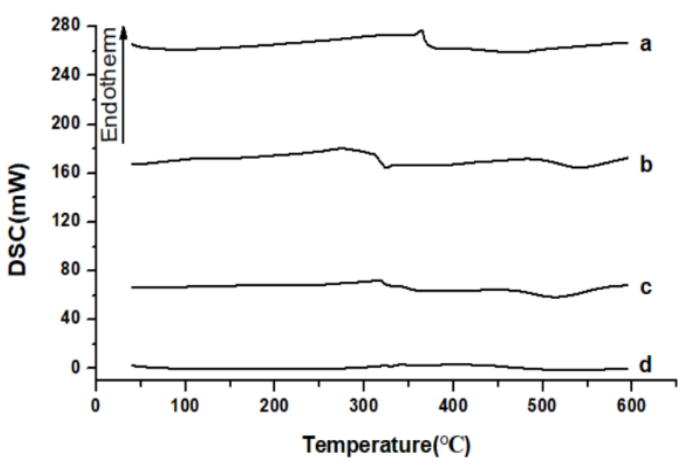
Figure 7. DSC results of samples. (a) Raw API, (b) API nanoparticles, (c) API and HP- β -CD mixture, and (d) HP- β -CD.